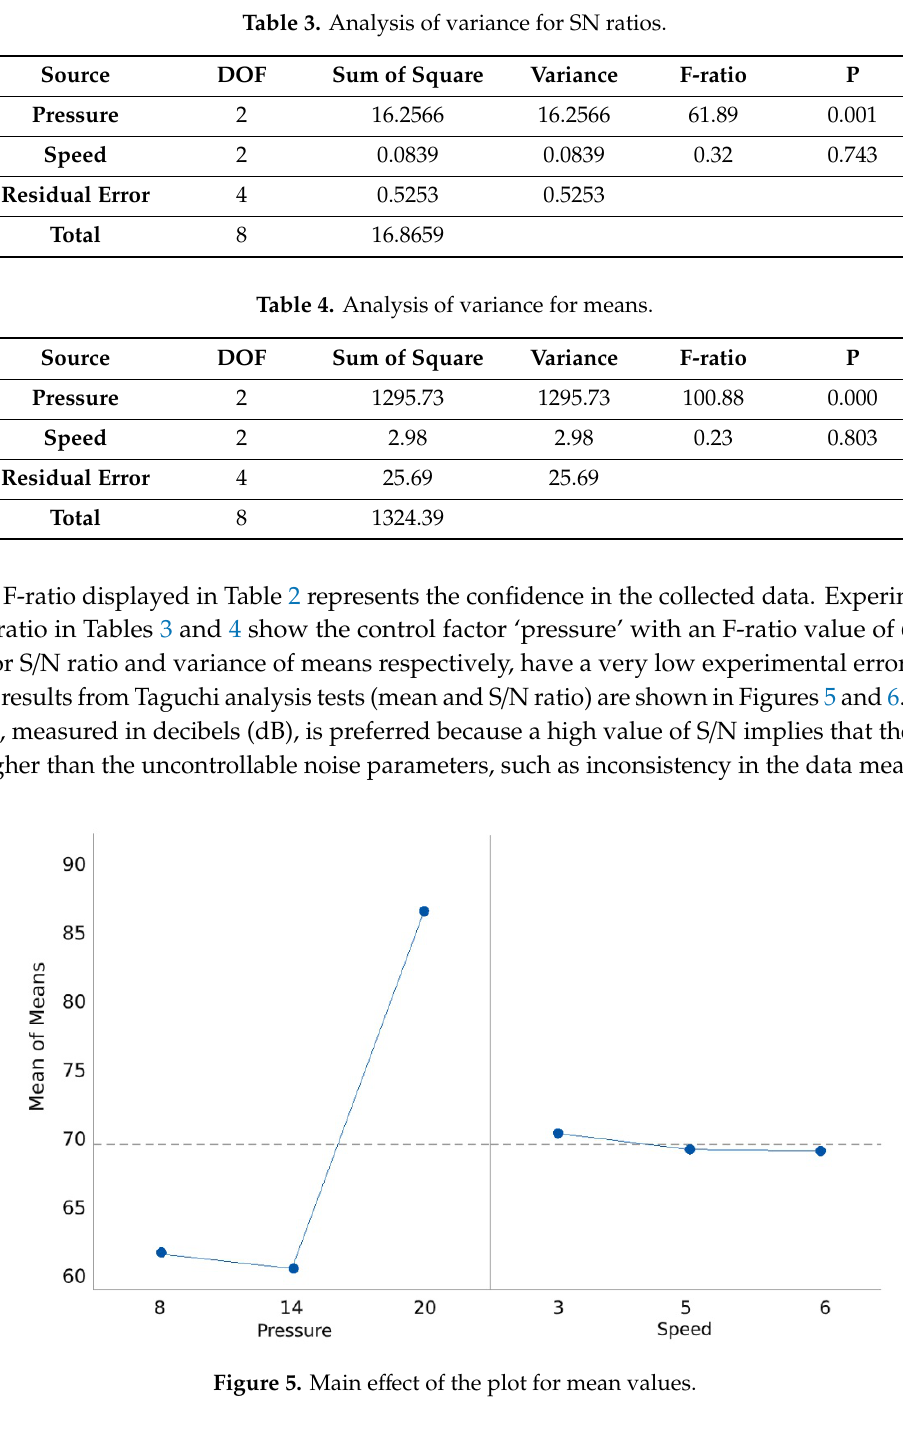
Figure 6. Main effects plot for S/N ratios. The main effect graph is plotted by determining the means for each value of a categorical variable. The analysis of the mean value shows that pressure has a significant effect on 3D print quality. However, the response mean for speed is almost the same across all parameter levels (Table 5). Table 5. Response table for S/N ratio. Level